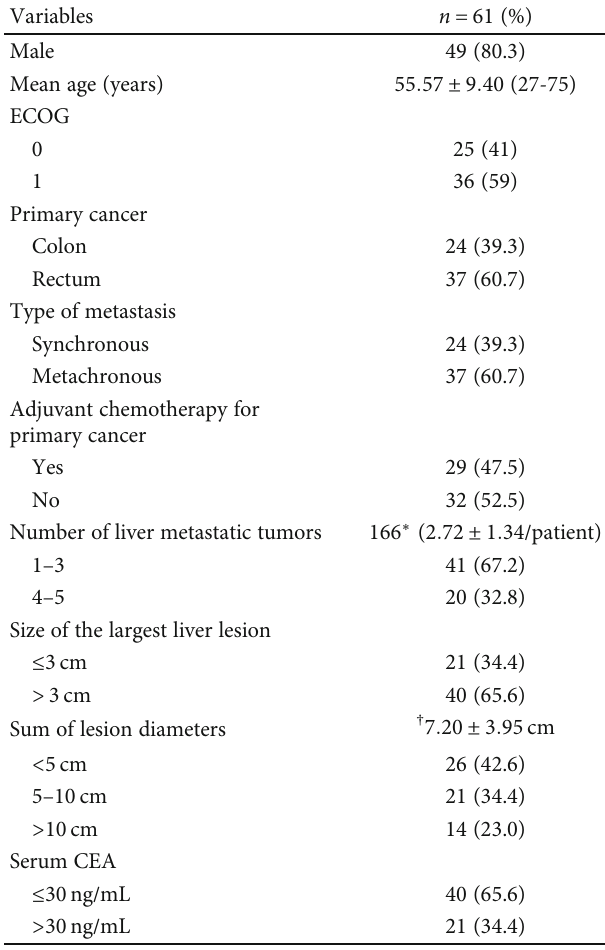
Table 1: Baseline characteristics of study participants ( n = 61